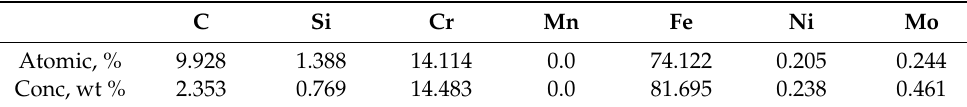
Table 3. Quantitative EDS analyses, respectively, from Point 2 (matrix).